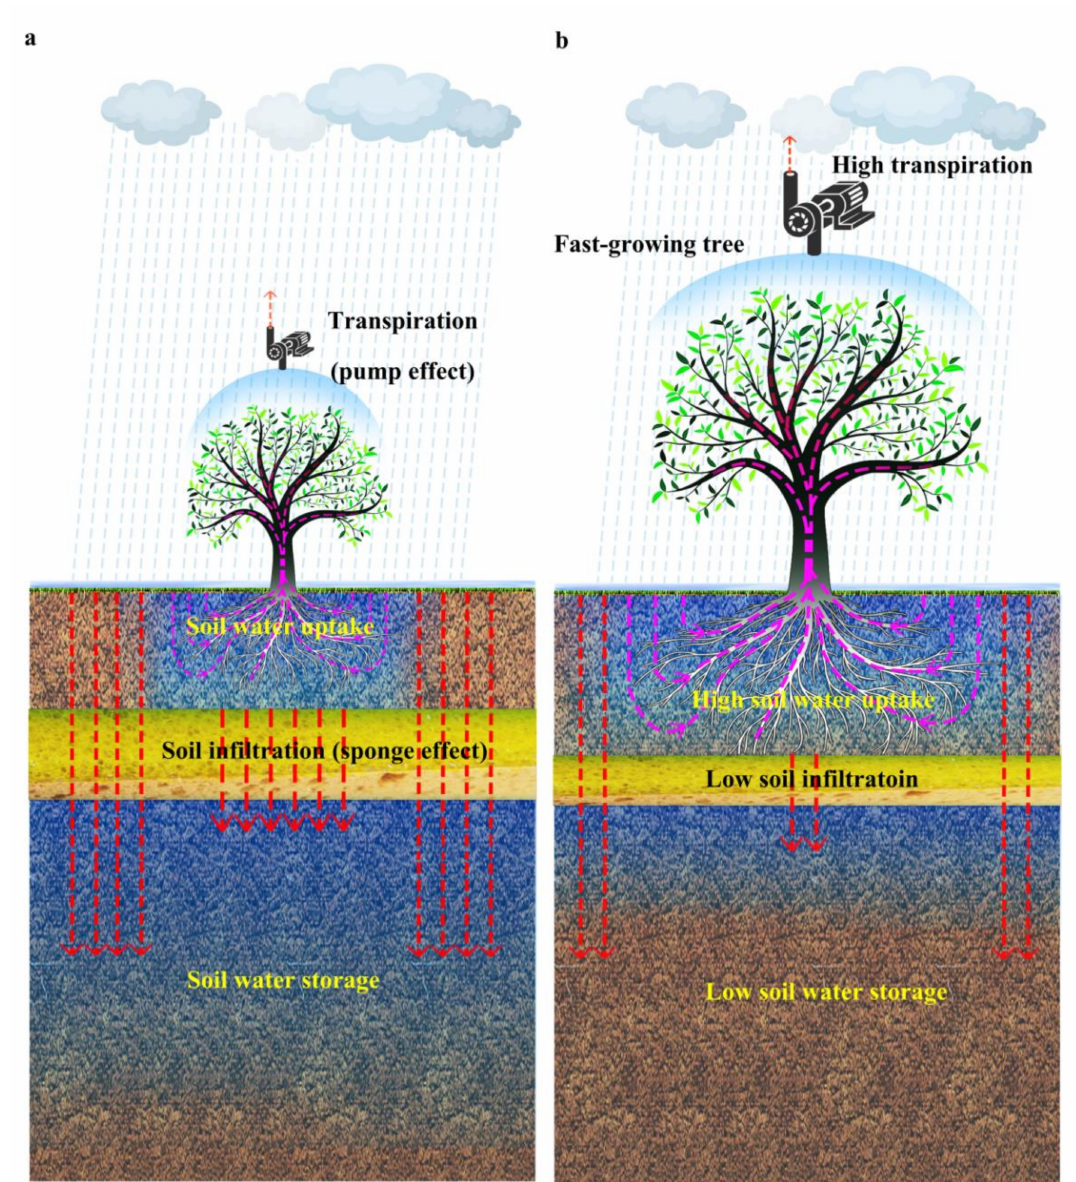
Figure 1. Hypothesizing ( a ) the roles of tree transpiration and soil infiltration, and ( b ) the influences of fast-growing tree species on soil water